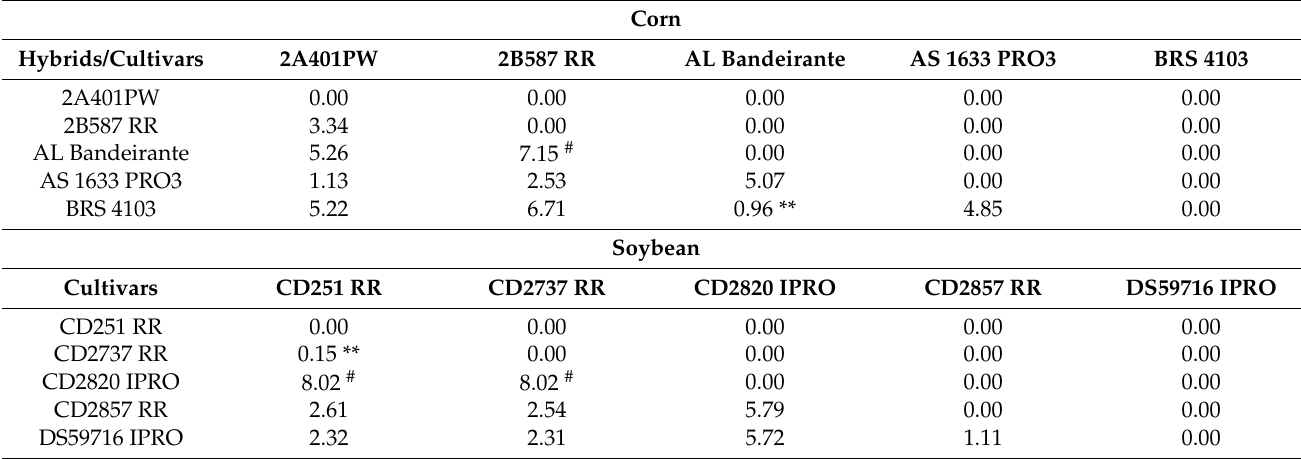
Table 8. Euclidean distances between corn and soybean hybrids and/or cultivars obtained using Ward’s method.